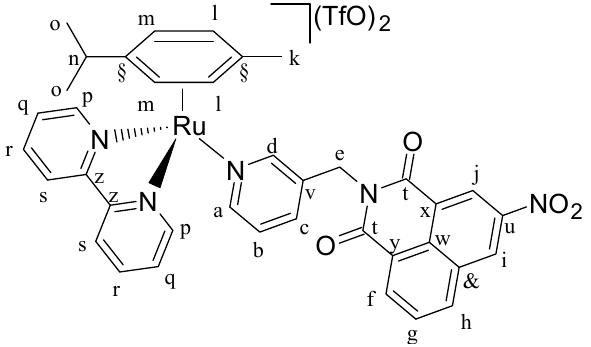
Figure 16 Structure of complex C2. Figure 16. Structure of complex [( η 6-p-cym)Ru(N,N (cid:48) -bpy)(L2)](SO3CF3)2 (C2) .